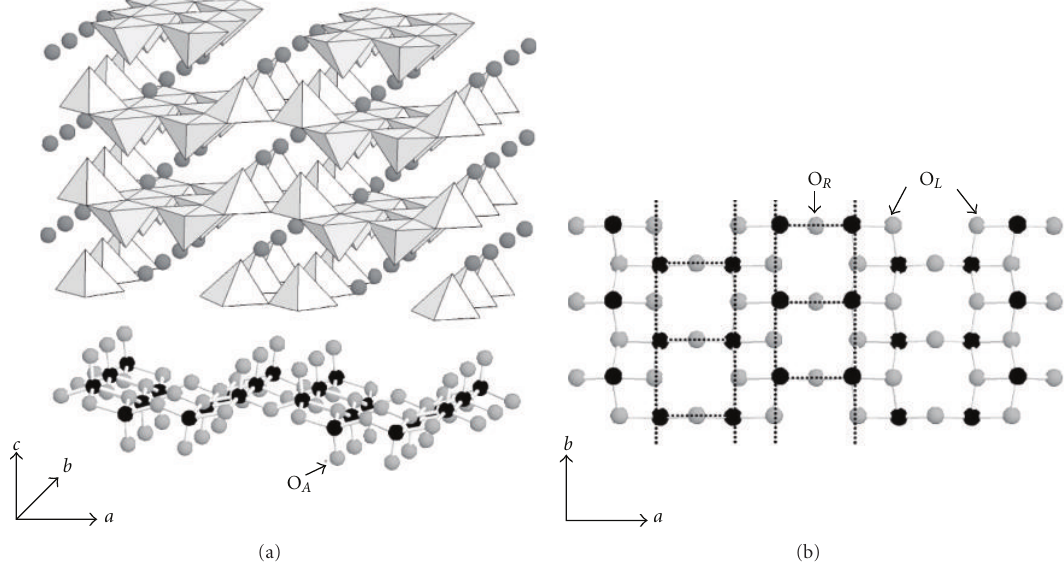
Figure 25: Crystal structure of α (cid:2) -NaV 2 O 5 . Vanadium atoms are shown as black spheres and oxygen atoms as grey spheres. (a) Layers of distorted VO 5 pyramids (upper part) separated by sodium ions (dark grey spheres) and the atomic ordering of a single vanadiumoxide layer (lower part). (b) Projection of a single VO layer onto the ab -plane, excluding the apex oxygens. The ladder structure is illustrated by the dashed lines.